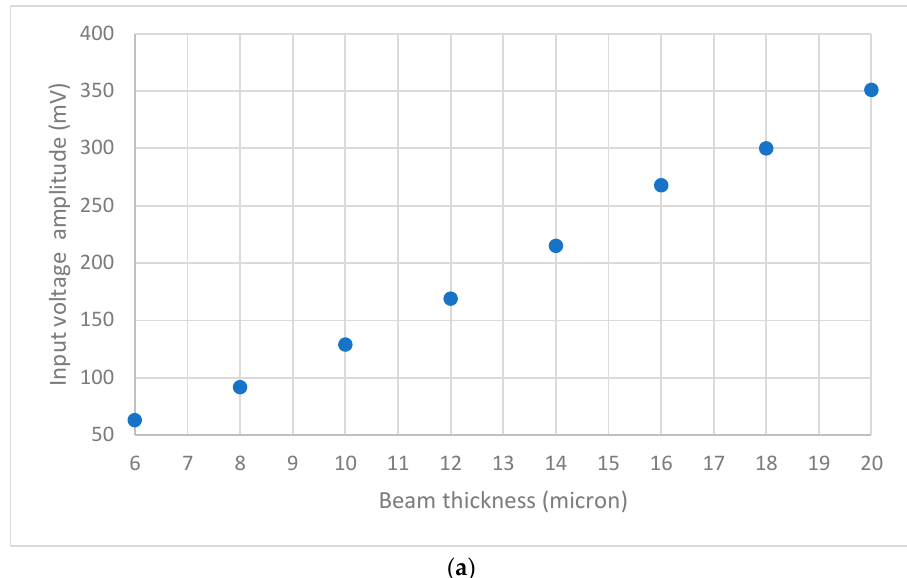
Figure 12. The effect of parasitic capacitance on the voltage amplitude dependence on dielectric constant.